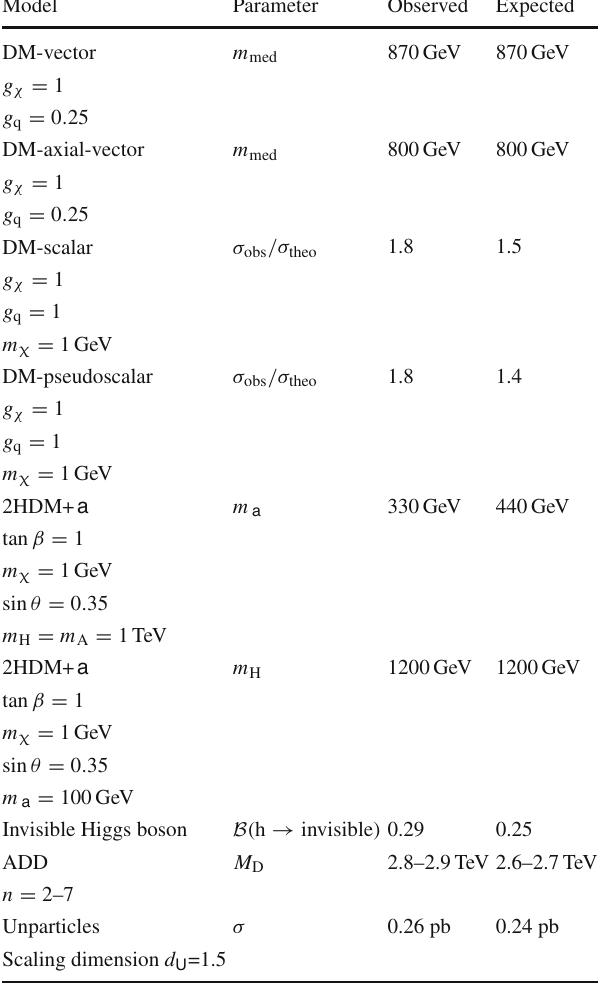
Table 5 Observed and expected 95% CL limits on parameters for the simplified DM models, invisible decays of the Higgs boson, two-Higgs- doublet model, large extra dimensions in the ADD scenario, and unpar- ticle model. For the scalar and pseudoscalar mediators, the limits are dependent on the mediator mass, so the lowest values for the ratio of observed to theoretical cross sections are presented. For the vector and axial-vector mediators, the limits are dependent on the DM particle mass, so the limits are shown for m χ < 300GeV for the vector media- tor and m χ = 240GeV for the axial-vector